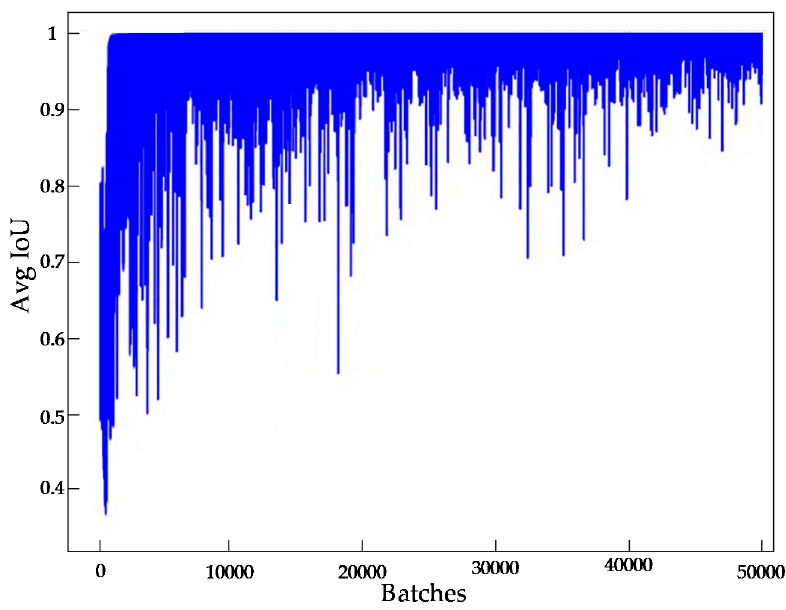
Figure 9. The curve of intersection over union (IoU).